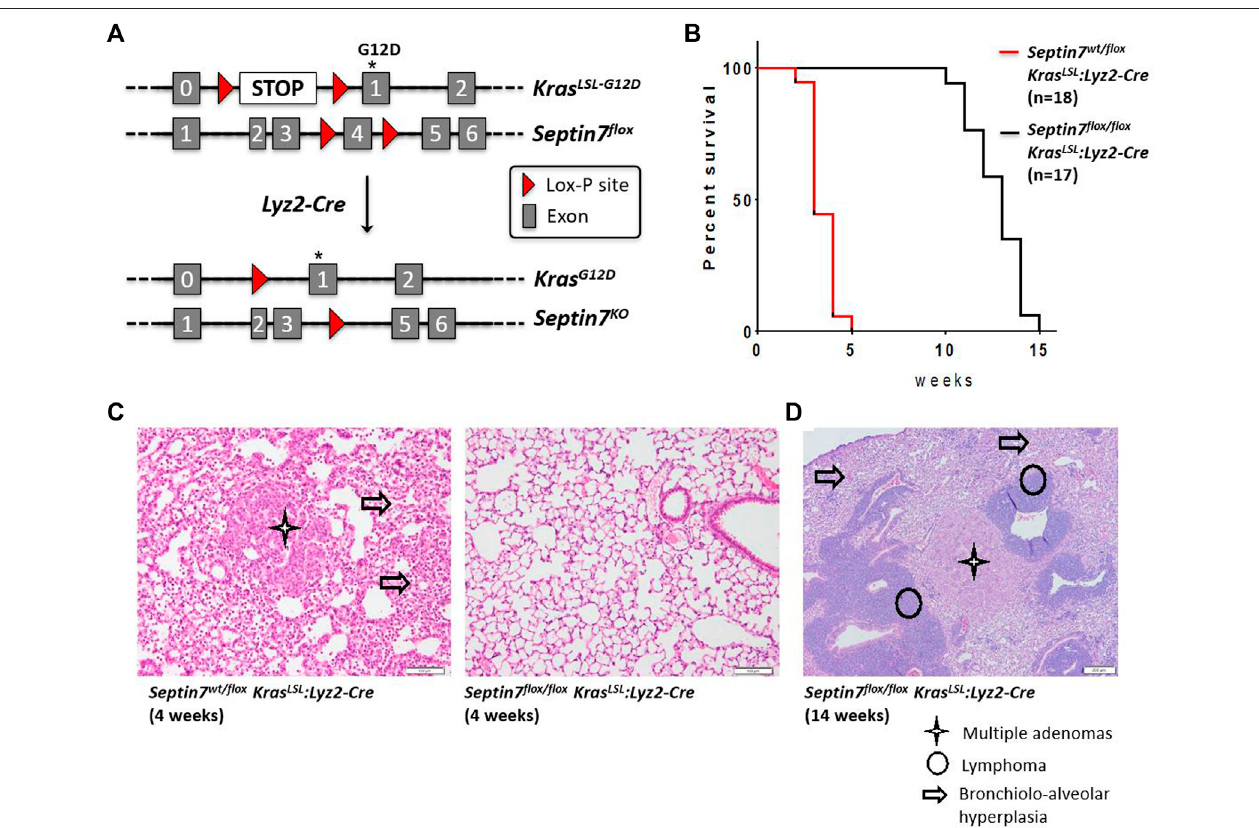
FIGURE 4 | Septin7 is essential for Ras-induced lung tumor formation and lethality in vivo . (A) The gene targeting strategy employed for the generation of a Kras- G12D-inducedlungtumormodeltomonitortheeffectsofSeptin7-de fi ciencyusingtheLyz2-Credeleterline. (B) Kaplan-Meiersurvivalplotsshowingtheessentialroleof Septin7 in lung cancer induced lethality in the Kras-induced tumor model. The survival curves are signi fi cantly different with a χ 2 (cid:1) 36.29 resulting in a p- value < 0.0001. (C) Representative images ofhematoxylin and eosin (H and E) stained lung sections from the mice ofindicated genotype at 4 weeks after birth. Cancer associated tissue alterations visible are indicated (scale bar (cid:1) 100 µm). (D) Lungs from Septin7-KO mice show late-onset adenomas and lymphomas as revealed in the standard histology H and E staining. Arrow (cid:1) bronchiolo-alveolar hyperplasia, star (cid:1) multiple adenomas and circle (cid:1) T cells lymphoma (scale bar (cid:1) 200 µm).